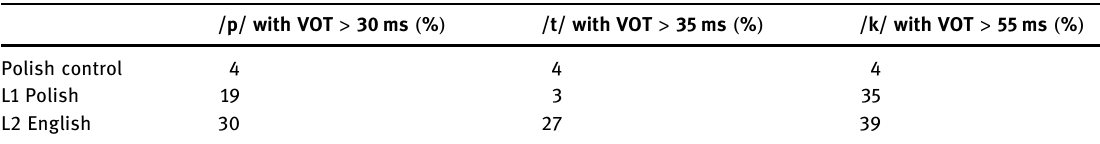
Table 4: Instances of voiceless stops with